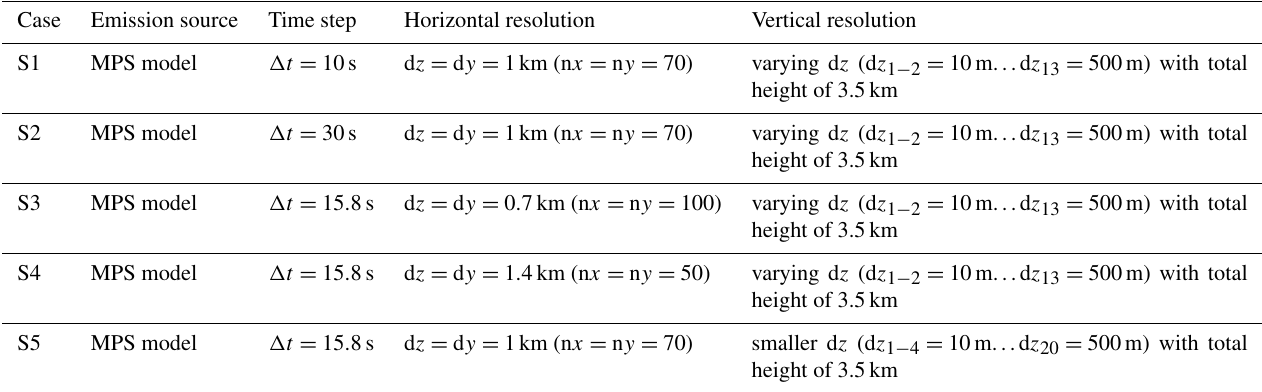
Table A1. Setups of pollutant dispersion modeling for parameter study.